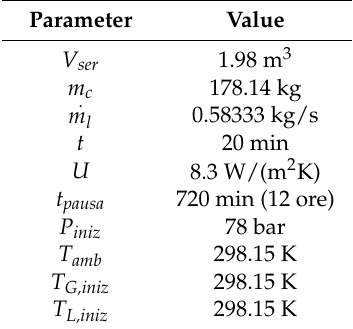
Table 1. Parameter utilized for the first configuration.